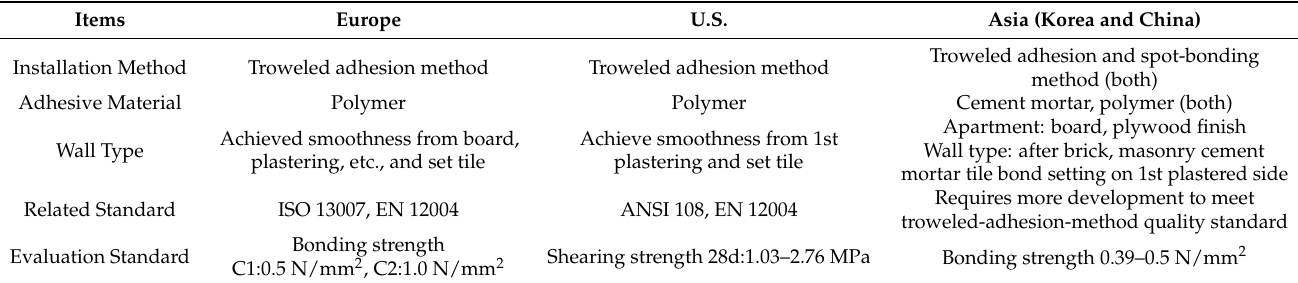
Table 1. International tile installation methods and related standards.